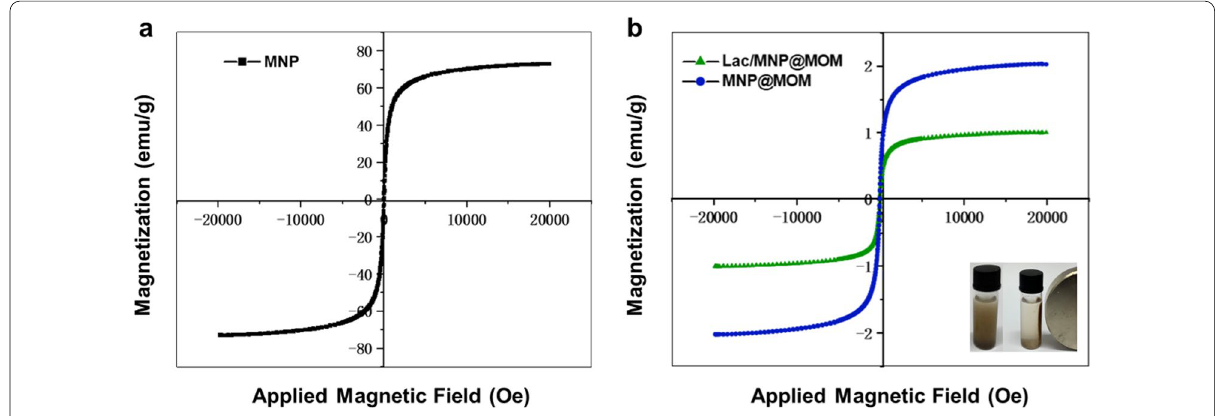
Fig. 3 VSM spectra of MNP ( a ), MNP@MOM and Lac/MNP@MOM ( b